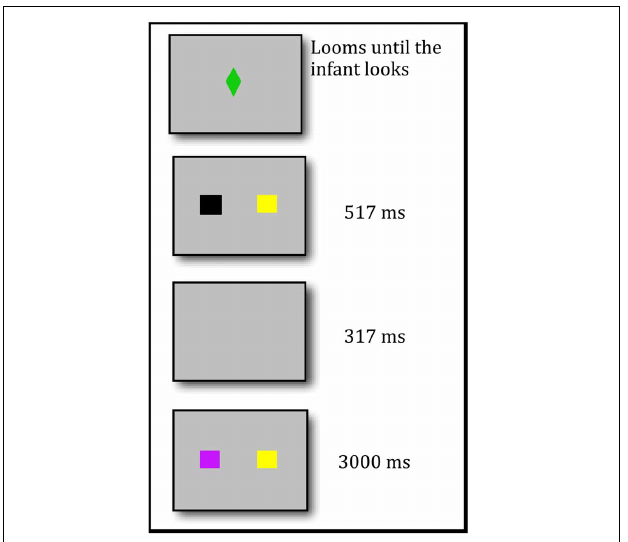
FIGURE 1 | A Sequence of events in a one-shot change detection